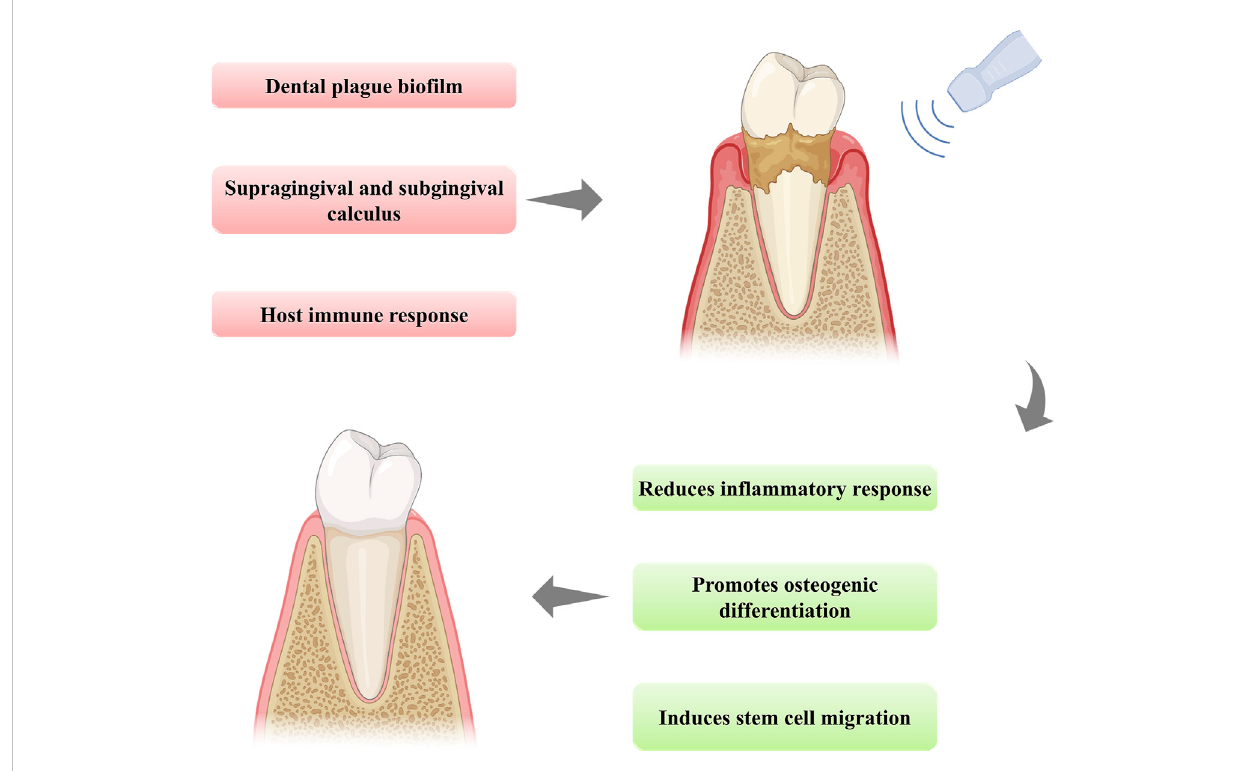
FIGURE 1 The schematic illustration of the function of LIPUS treatment in